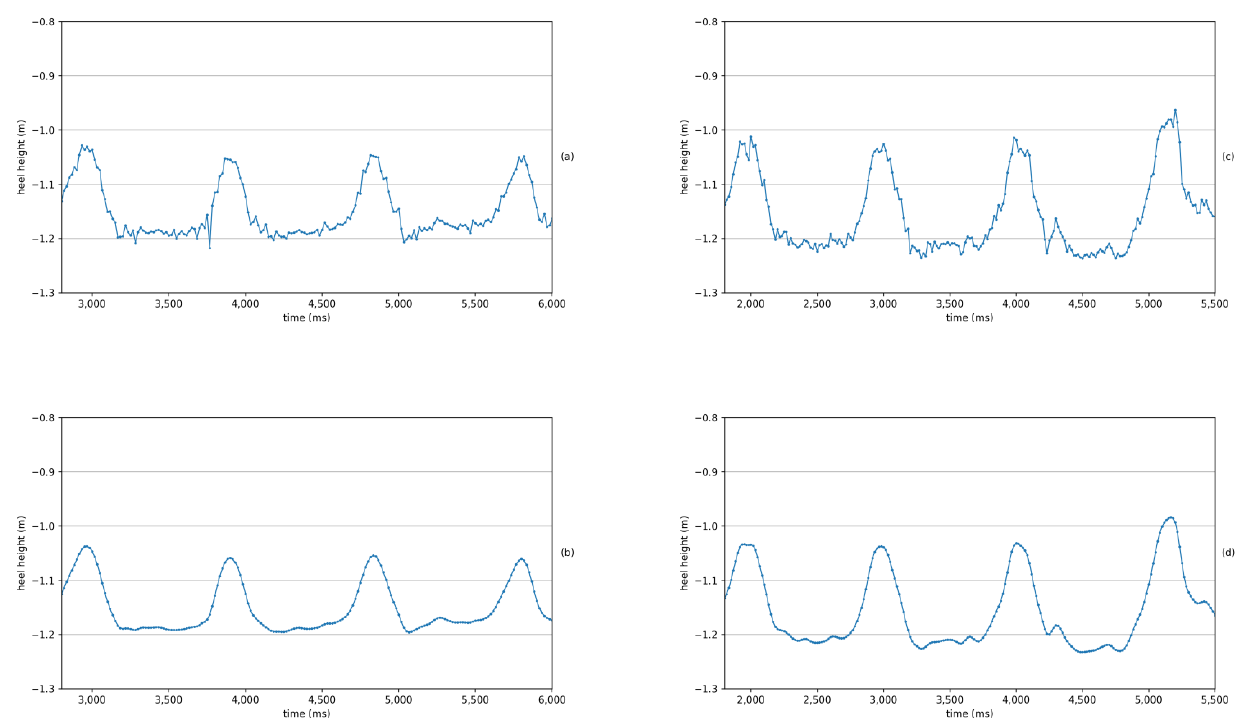
Figure 10. Plot of heel height for two paired subjects: ( a ) patient subject heel height; ( b ) patient subject smoothed heel height, where false positives and false local extremes have been removed; ( c ) control subject heel height; ( d ) control subject smoothed heel height, where false positives and false local extremes have been removed;